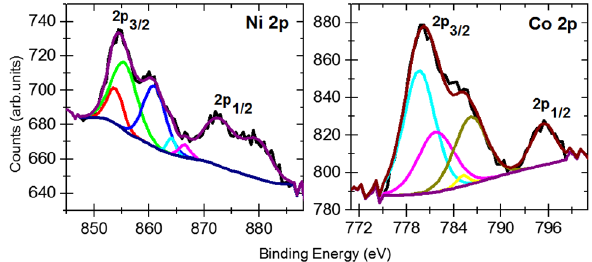
Fig. 3 High-resolution core level XPS spectra of Ni 2 p and Co 2 p of the Co–Ni nanoparticles layer pulsed-laser-deposited onto MWCNTs, at N LP =